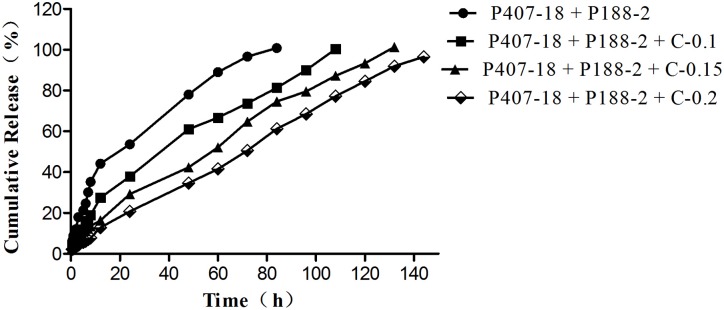
Release profiles of APS from in-situ forming gel formulations containing CMC-Na with different concentrations in PBS at 37°C (n = 3; error bars were omitted for clarity).